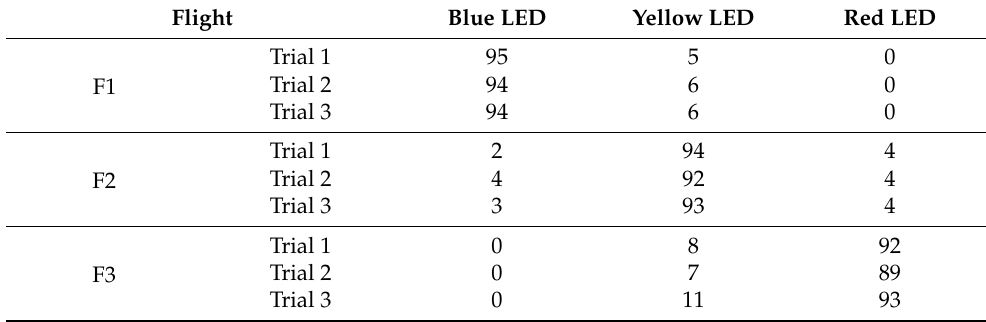
Table 6. Tracking Three LEDs from Nine